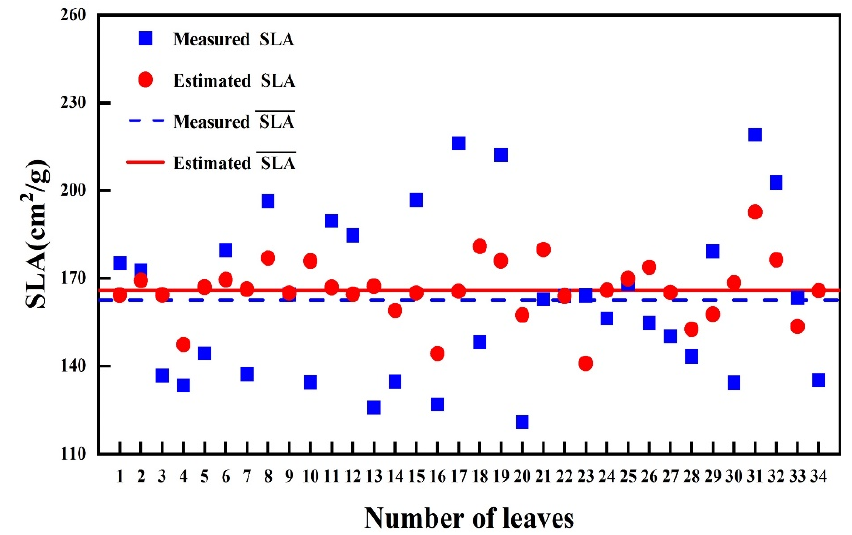
Figure 6. Measured and estimated SLAs of bamboo species Phyllostachys parvifolia . A total of 34 leaves represented 25% of the validation dataset of Phyllostachys parvifolia without multiple sam- pling.